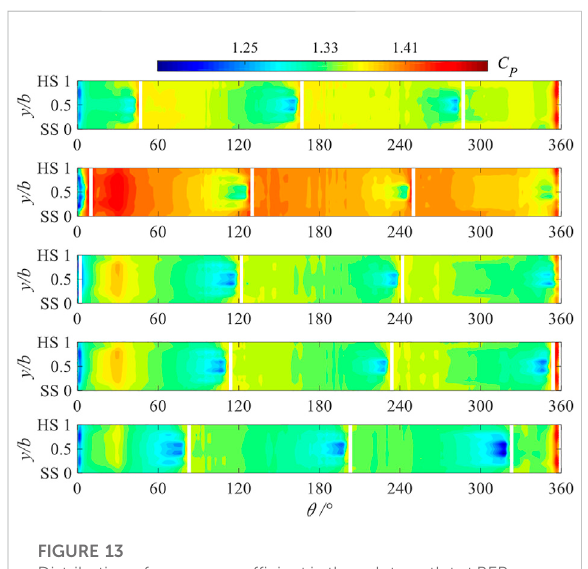
Distributionofpressurecoef fi cientinthevoluteoutletatBEP. Distribution of radial velocity in the volute outlet under